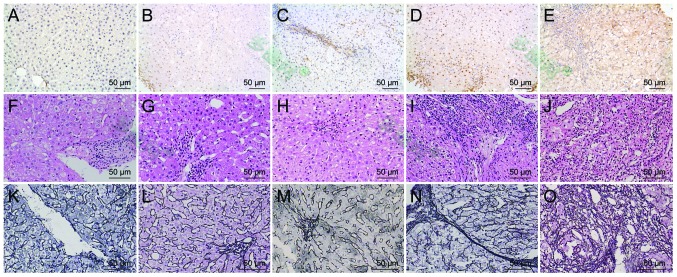
β-catenin was upregulated in liver fibrogenesis. (A–E) Immunohistochemical analysis of β-catenin distribution and expression in liver fibrosis specimens (original magnification, ×400). Brown color signifies positive expression. (A) No immunoreactivity was detected in the normal liver tissue; (B) weak staining in liver fibrosis tissue at F1; (C and D) moderate staining in liver fibrosis tissue at F2 and F3; (E) strong staining in liver fibrosis tissue at F4. (F–J) Hematoxylin and eosin was used to examine pathological alterations and collagen deposition. Images F–J indicate fibrosis stages F0, F1, F2, F3 and F4, respectively. (K–O) Silver staining of reticular fibers was used to examine pathological alterations and collagen deposition. Images K–O indicate fibrosis stages F0, F1, F2, F3 and F4, respectively. F0, no fibrosis; F1, enlarged fibrotic portal tracts; F2, periportal or portal-portal septa, but intact architecture; F3, fibrosis with architectural distortion, but no obvious cirrhosis; F4, cirrhosis.